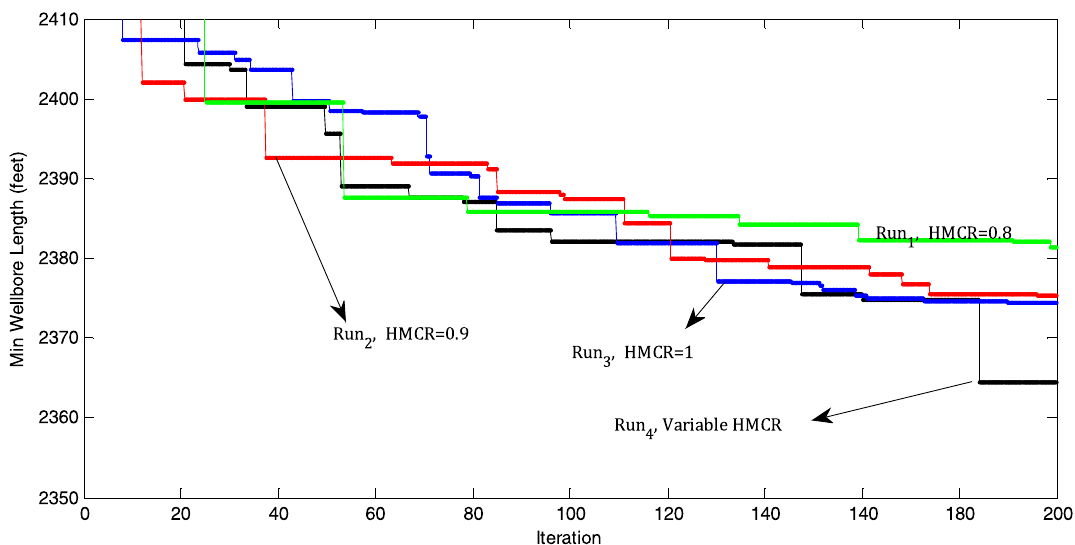
Fig. 11 Performance comparison of tuned HS versus non-tuned con- stant HMCR–HS for well-path Case 1. Variable HMCR runs tend to yield better optimum values of the objective function because the